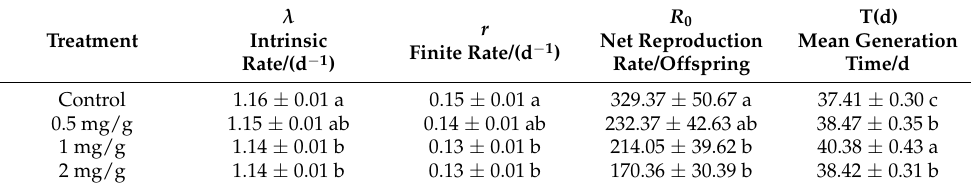
Table 6. Population parameters of Spodoptera frugiperda fed with different GO concentrations.